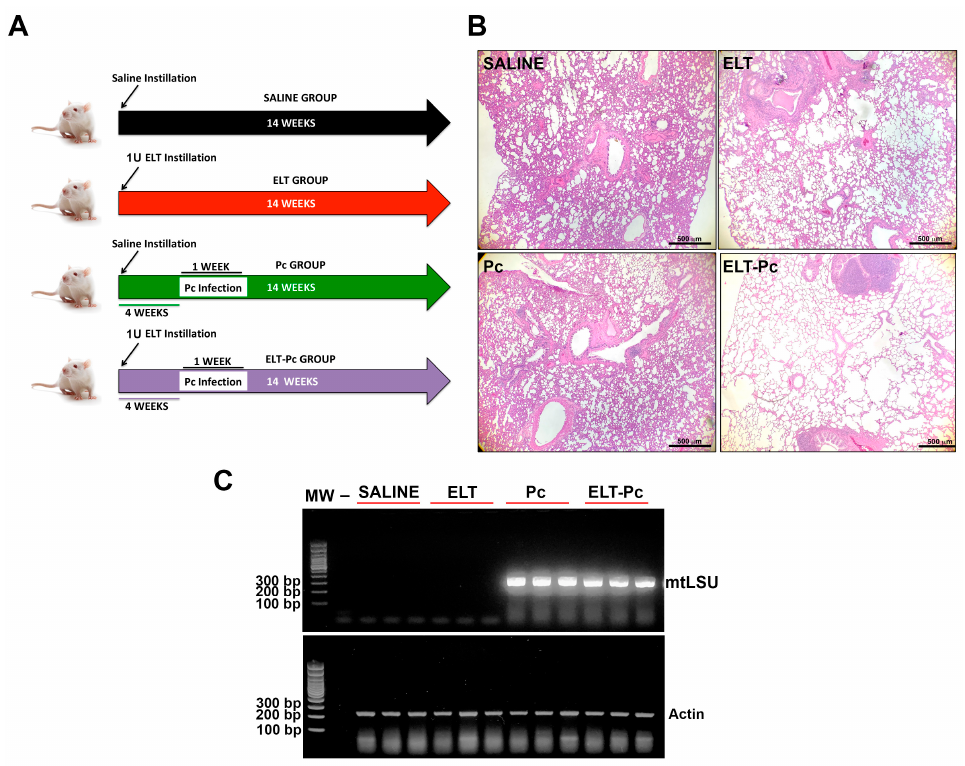
Figure 1. Evaluation of elastase-induced lung lesions. ( A ) Scheme of the animal model indicating the four experimental groups: Saline, Elastase (ELT), Pneumocystis infection (Pc), and Elastase- Pneumocystis infection (ELT-Pc). The experiment took 14 weeks total in all experimental groups. This time included the one-week of cohabitation with Pneumocystis -seeding rats starting 4 weeks after elastase instillation in the Pneumocystis groups. ( B ) Alveolar spaces were evaluated in lung sections from rats of the four groups using hematoxylin-eosin (H/E) staining. Microscopic analyses were performed using 40× magnification. ( C ) Pneumocystis infection was evaluated in the animals using PCR amplification of the mitochondrial large subunit (mtLSU) rRNA. Amplification of actin was used as internal